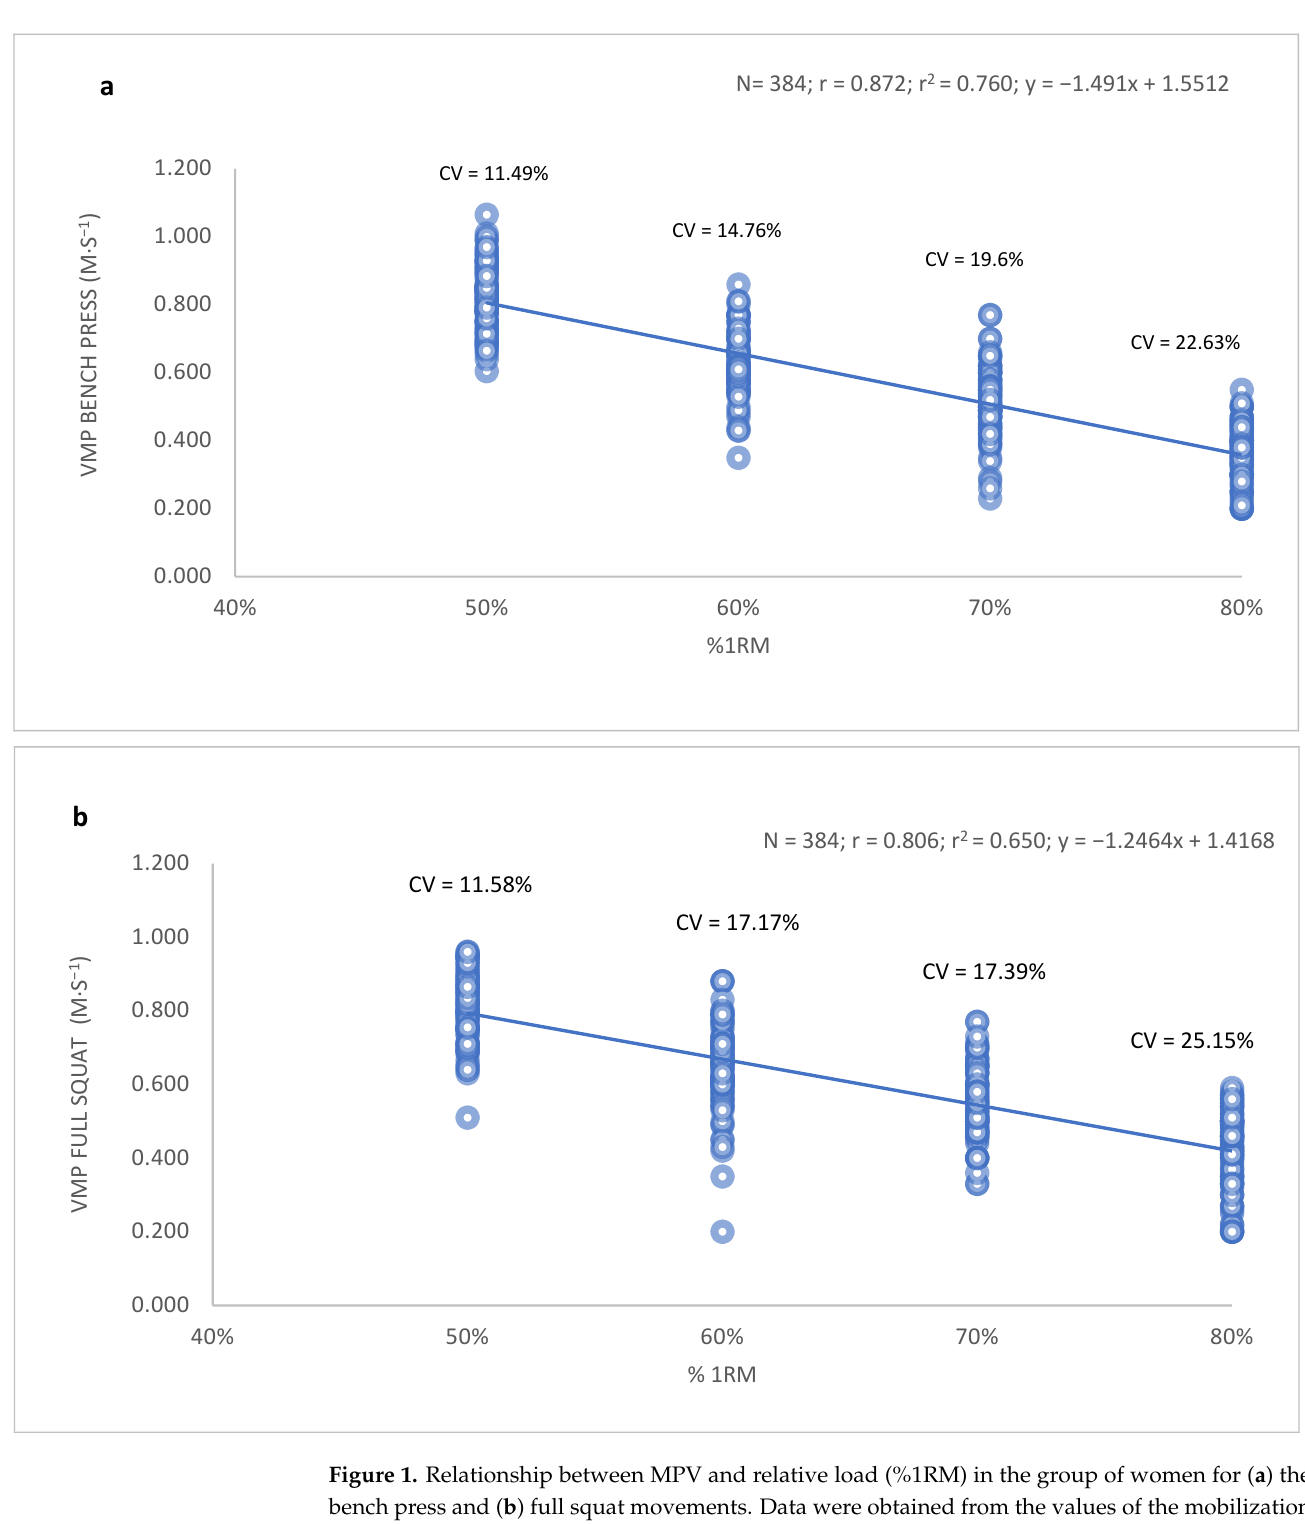
press. *** p < 0.001, ** p < 0.01, * p < 0.05.